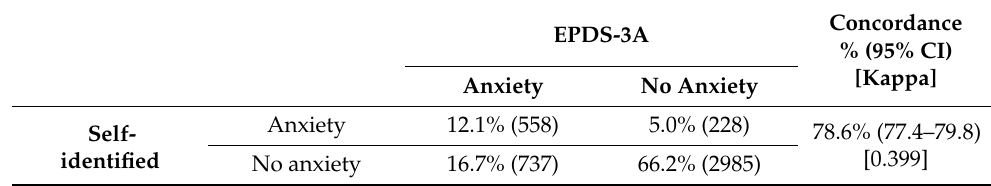
Table 3. Concordance and kappa values for self-identified anxiety and EPDS-3A (n = 4508).